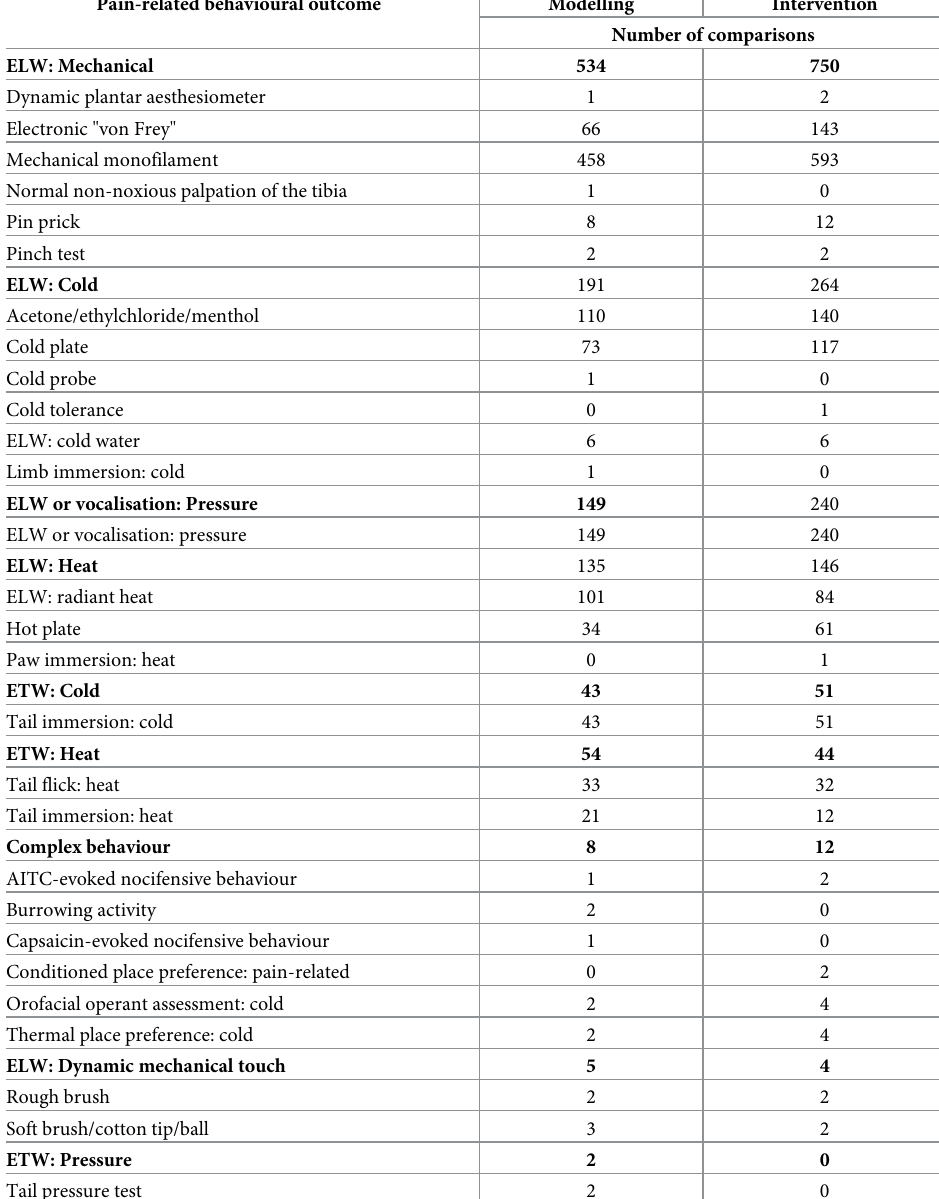
Conditioned place preference: pain-related 0 2 Orofacial operant assessment: cold Thermal place preference: cold 4 Rough brush Tail pressure test 2 0 Frequent descriptions for ELW or vocalisations: pressure (with the Randall-Selitto/paw pressure test). Frequent description for ELW: radiant heat (with